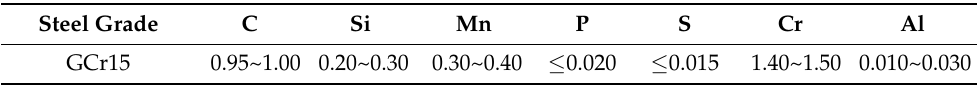
Figure 6. Layout of the 9# bloom caster and its technical parameters. Table 1. Chemical composition 1 of the tested bearing steel, wt.%.